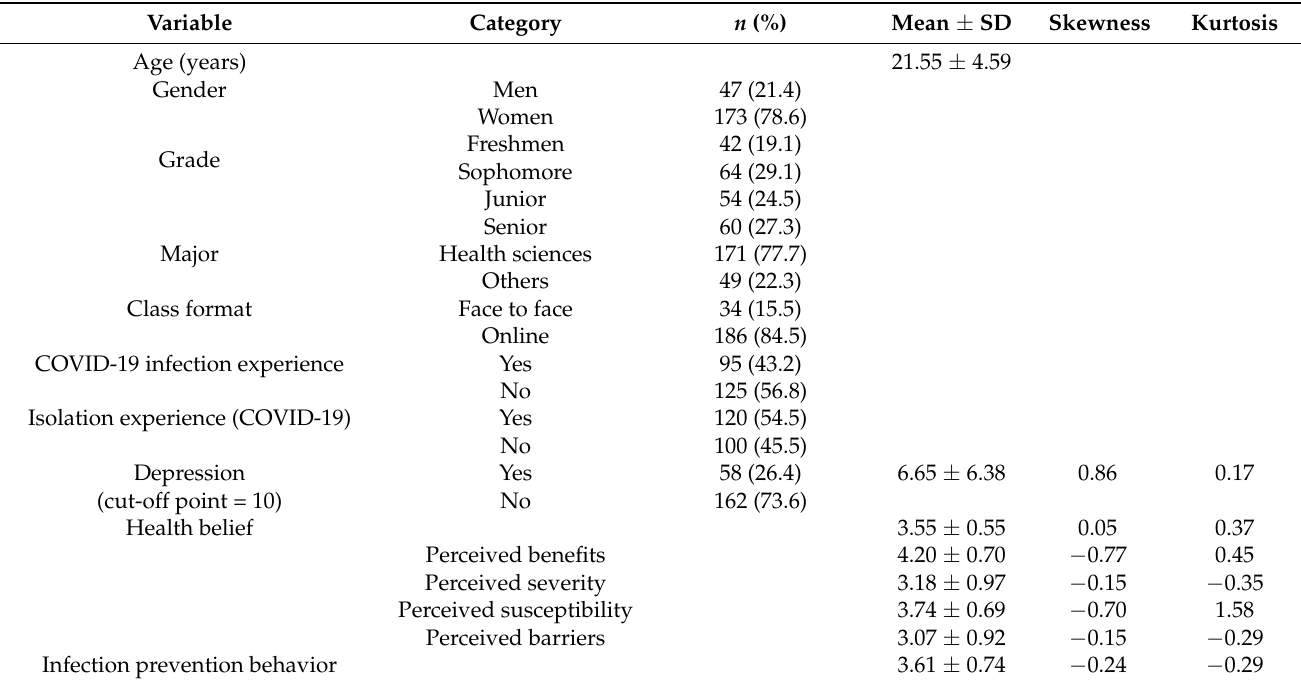
Table 1. Sociodemographic characteristics of participants ( n = 220).